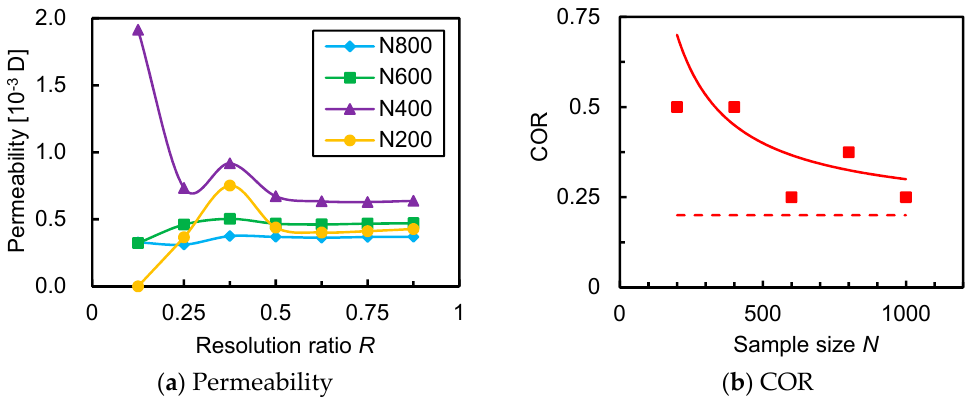
Figure 9. Influence of sample size on resolution effect. ( a ) Resolution effect on calculated permeability at varying sample sizes; ( b ) Influence of sample size on COR. Solid line is schematic plot and dashed line is asymptotic line of solid line.